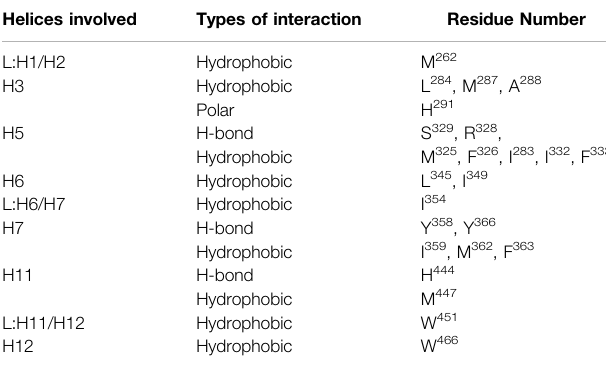
TABLE 1 | Interaction analysis of the FXR complex system with ‘ OCA ’ within the 4.0 Å area of the pocket. Helices involved